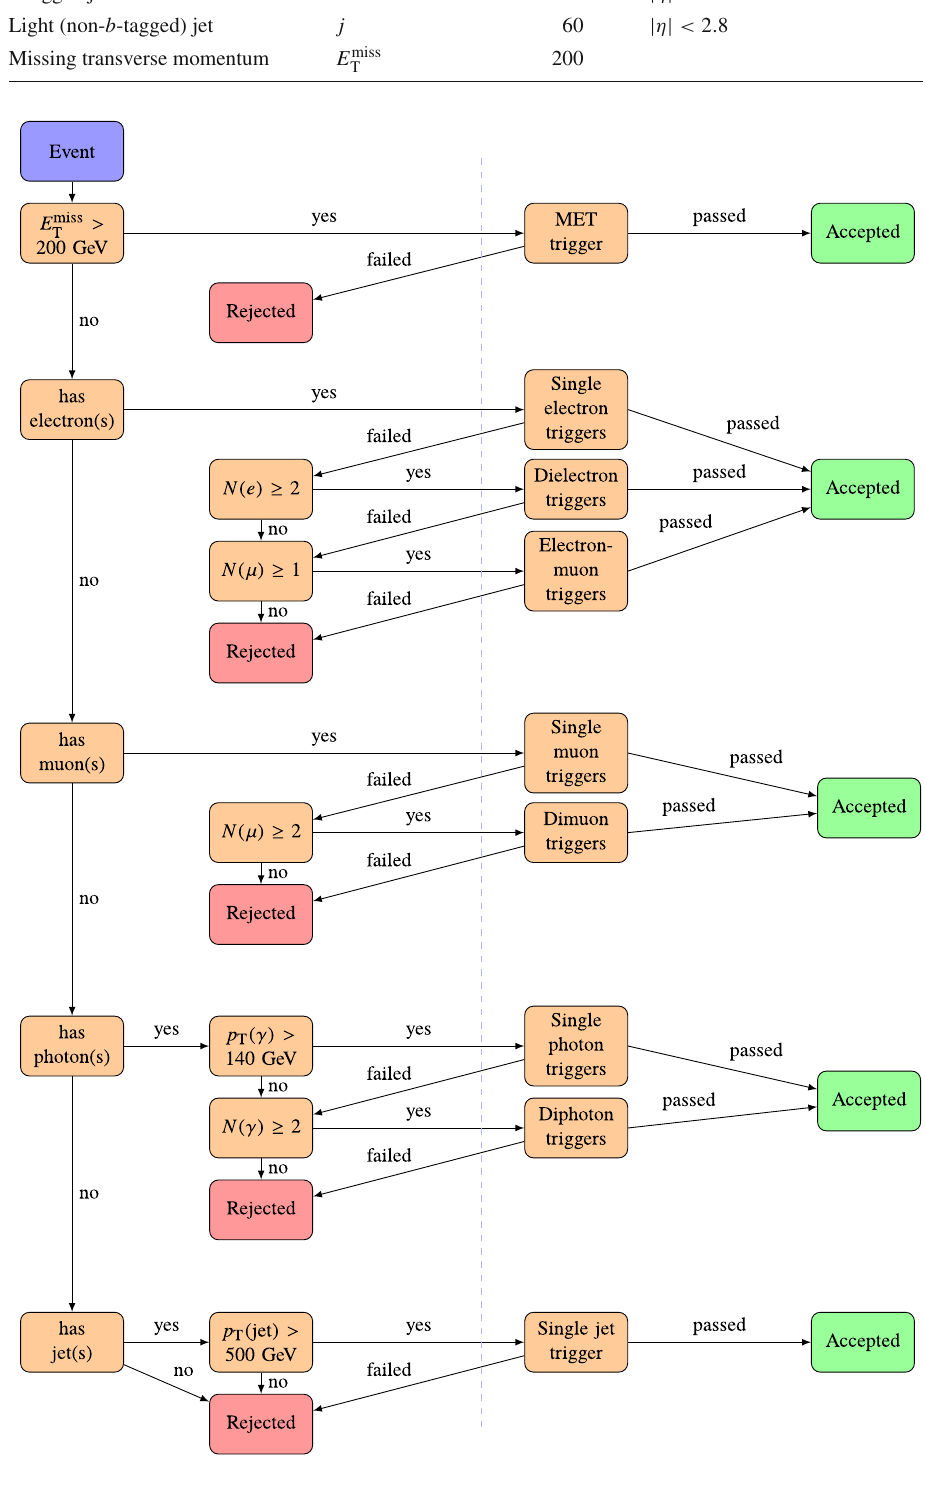
used for classifying the events, with their corresponding label, minimum p T requirement, and pseudorapidity requirement